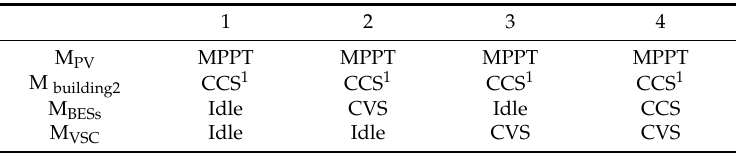
Table 1. Operation modes of converters. CCS: current-controlled source; CVS: controlled voltage source; MPPT: maximum power point tracking.